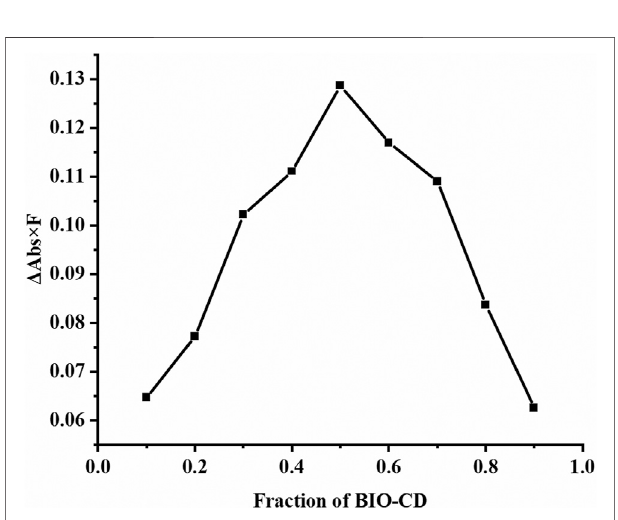
FIGURE 2 | Job plot for the inclusion system of AD-CBD/BIO-CD at λ (cid:1) 280 nm [(AD-CBD) + (BIO-CD) (cid:1) 1.0 × 10 – 3 mol · L − 1 ] in methanol-water solutions (55: 45,